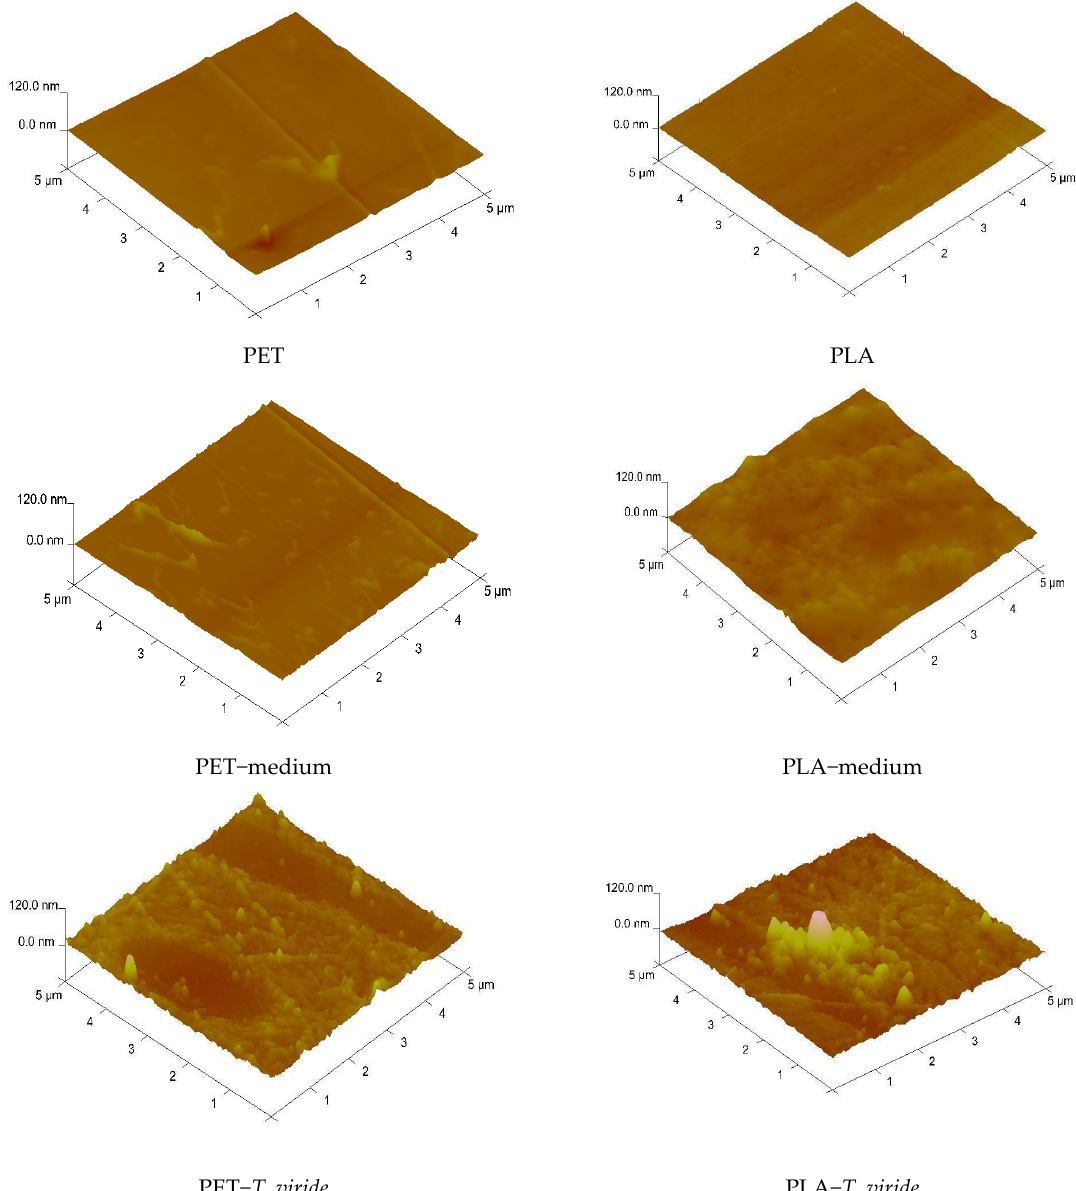
Figure 6. Atomic force microscopy (AFM) images of PET (left-hand side) and PLA (right-hand side) before treatment, after 3-month incubation in medium, and after 3-month incubation in medium- T. viride GZ1.